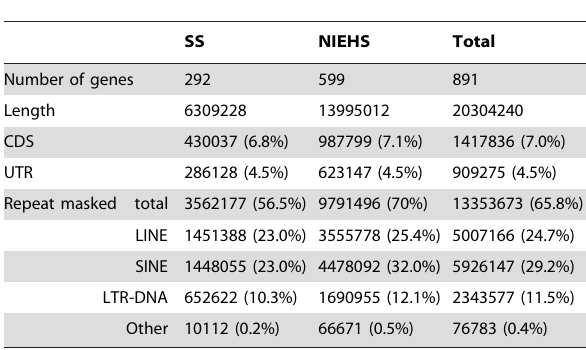
Table 1. Summary of